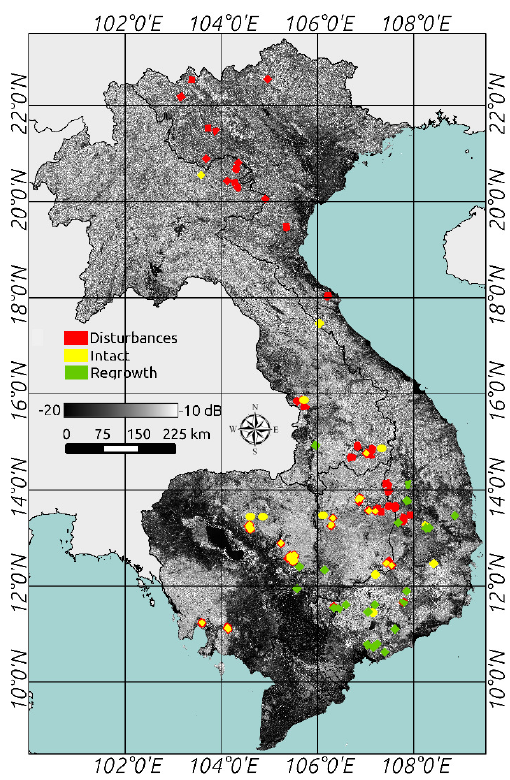
Figure 1. Polygons of natural, disturbed and regrowth forest areas in Vietnam, Cambodia and Lao PDR between 2007 and 2010 drawn by visual interpretation of high- and very high-resolution optical images superposed over HV-polarized 2010 ALOS